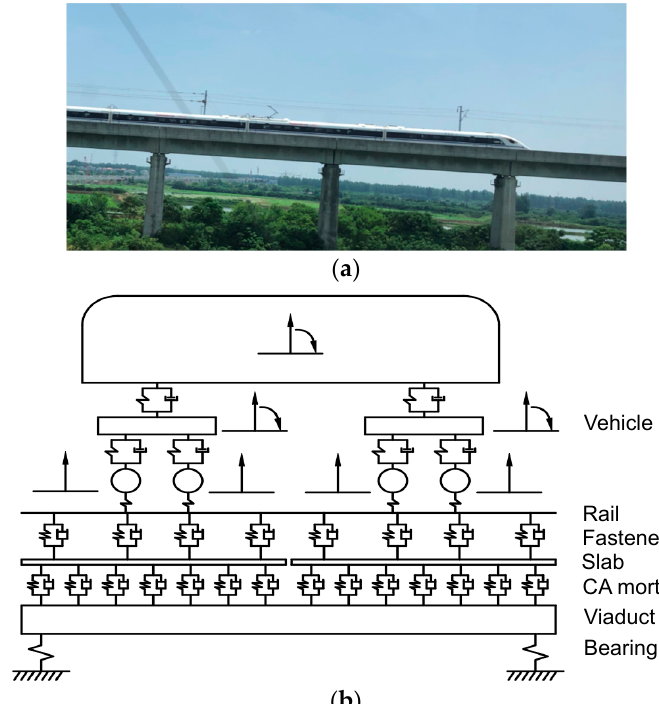
Figure 2. Vertical model of vehicle-track coupling system: ( a ) high-speed railway (HSR) system; ( b ) vehicle-rail-viaduct coupled model.